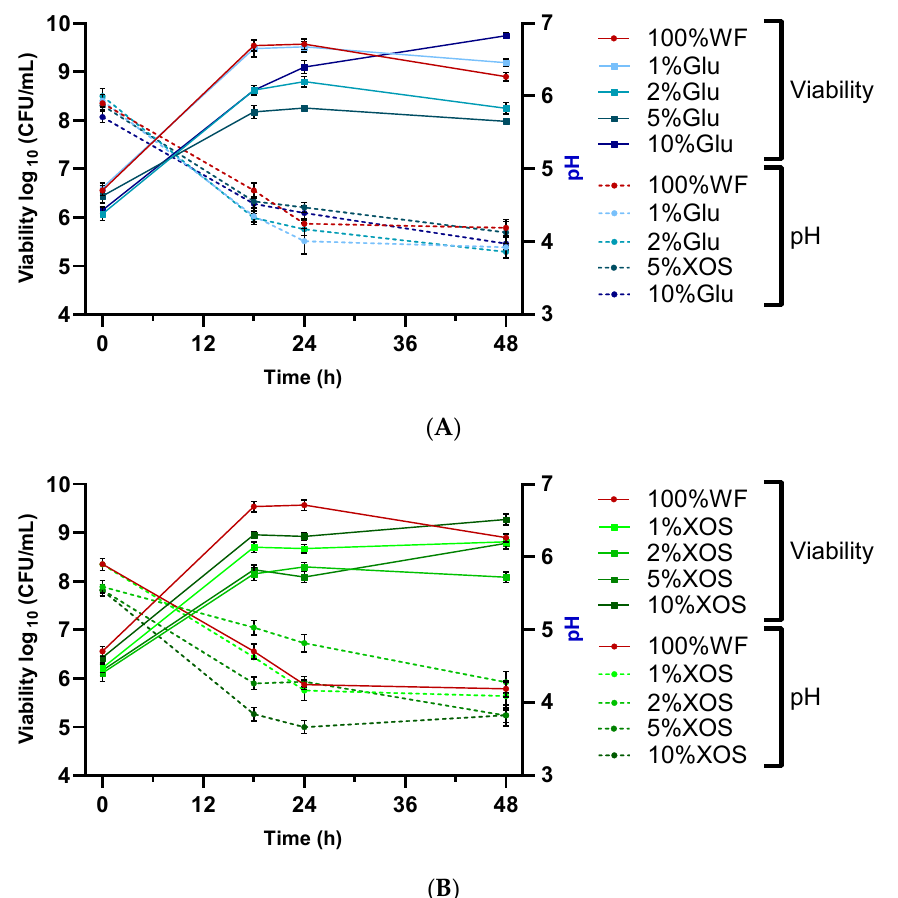
Figure 1. Cell viability (continuous line) and pH (dotted line) of dough fermented with BB-12. Three fermentation varieties with 100 % WF were made: ( A ) with 1, 2, 5, and 10% glucose of addition and ( B ) with 1, 2, 5, and 10% of XOS addition. The viable cell counts of BB-12 and pH are presented as mean values ± SD, log10 CFU/mL, n = 3.